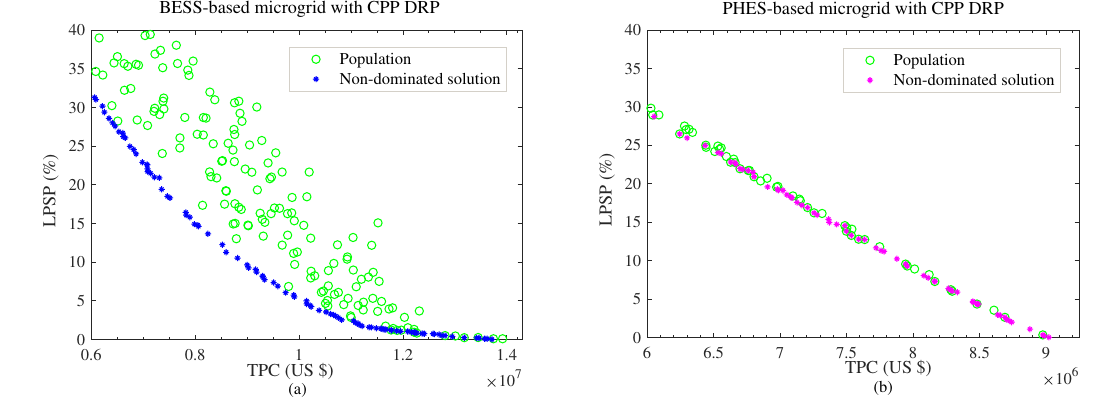
Figure 5. Pareto front for case 2. Table 4. Techno-economic analysis for case